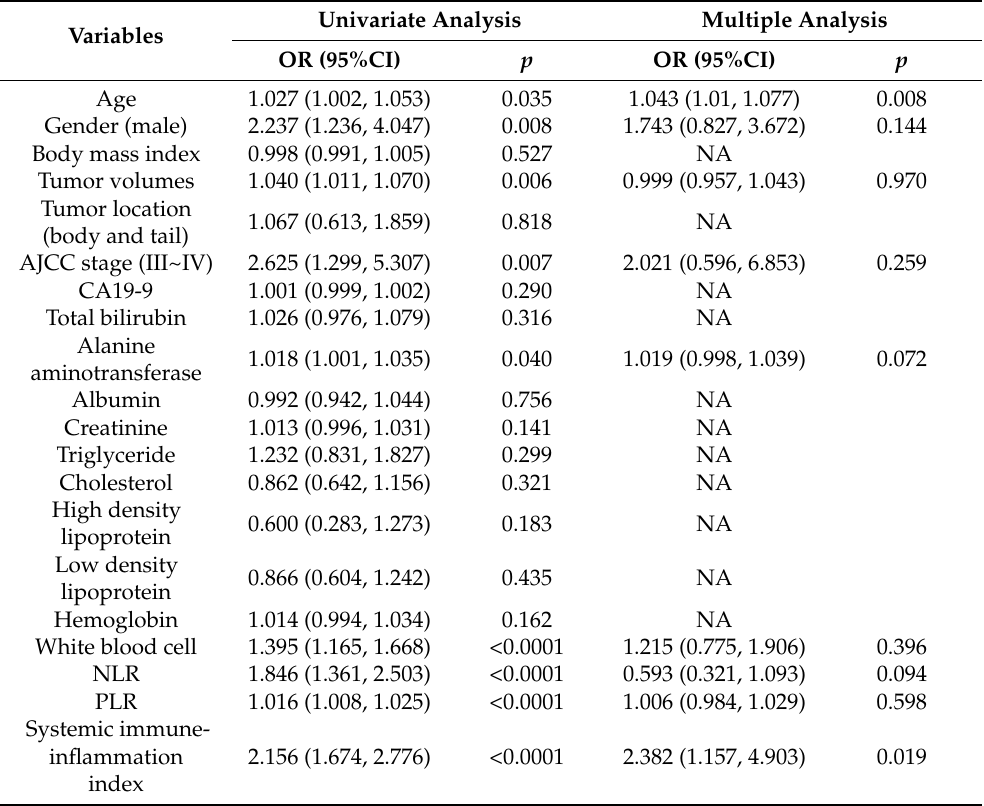
Table 3. ORs for diabetes mellitus by logistics